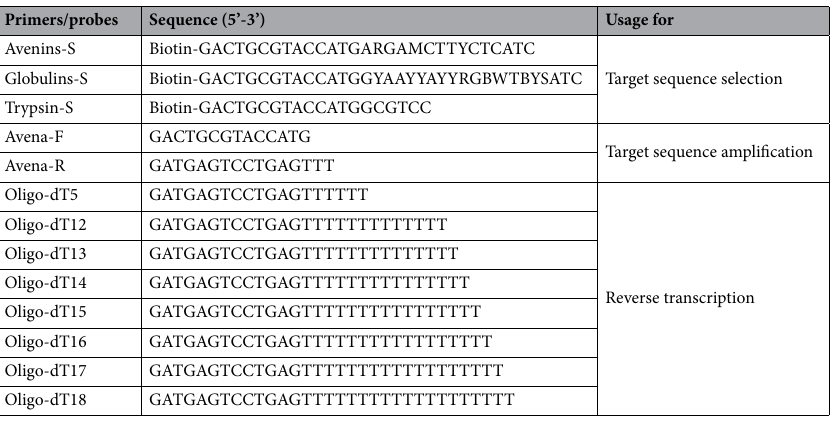
Table 1. Primers, oligos and probes used in the